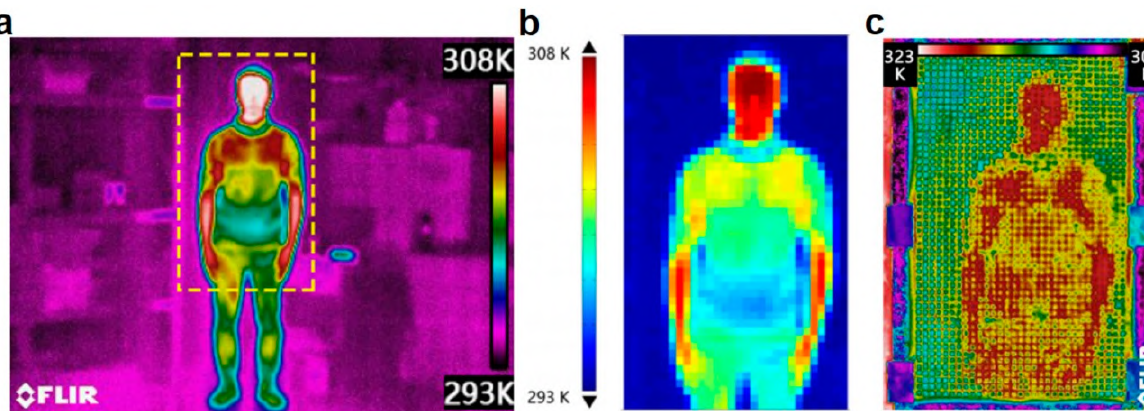
Figure 7. Thermal metamaterials for human recognition. ( a ) infrared image of a human body. ( b ) Digital discretization of the original infrared image to 31 × 51 = 1581 pixels. ( c ) experimental infrared image of the digital metasurface to show the thermograms of a human body. Reproduced with permission from [116]. Copyright 2018, American Institute of